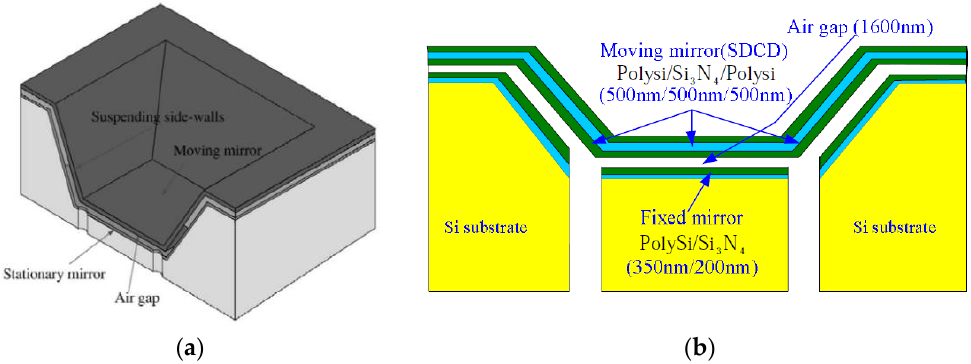
Figure 10. ( a ) Three-dimensional schematic with cross section of the proposed SDCD FP microcavity pressure-sensing element (Reproduced from [58]); ( b ) Schematic view of the proposed F-P microcavity pressure sensor (Reproduced from[51]).